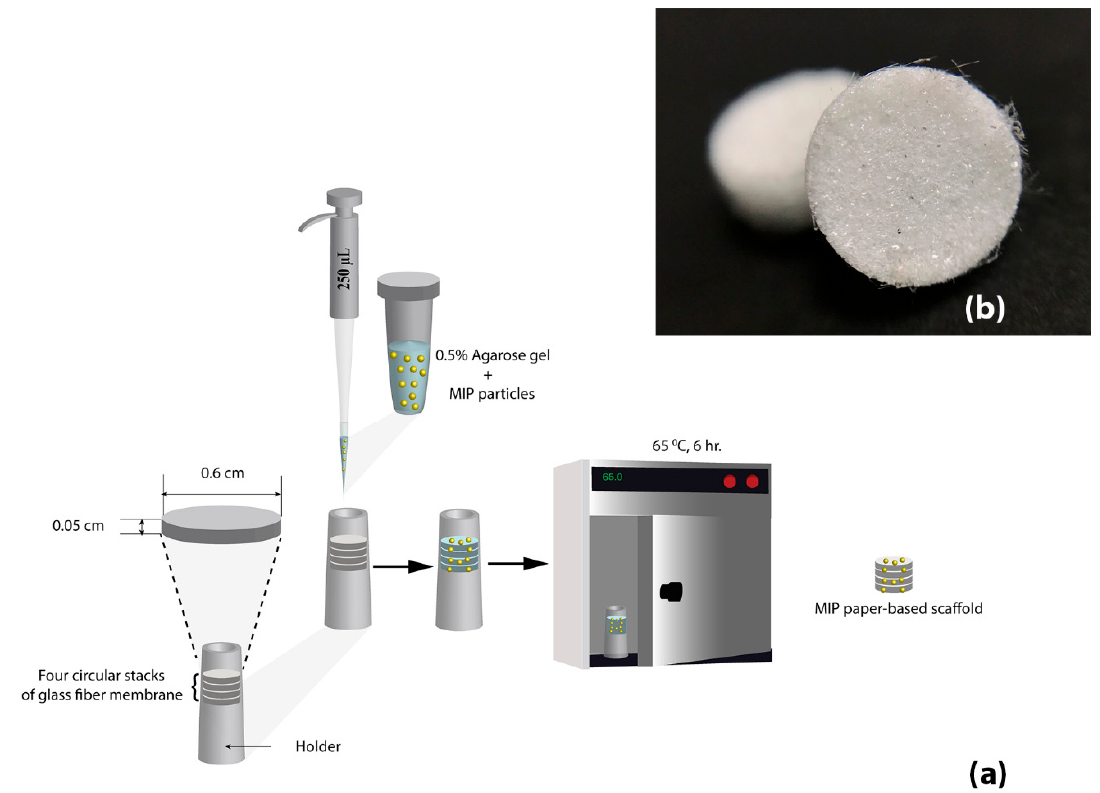
Figure 1. ( a ) Schematic of molecularly imprinted polymer (MIP) paper-based scaffold preparation. ( b ) Microscopic image of MIP paper-based scaffold observed under a stereo microscope (9.7×).